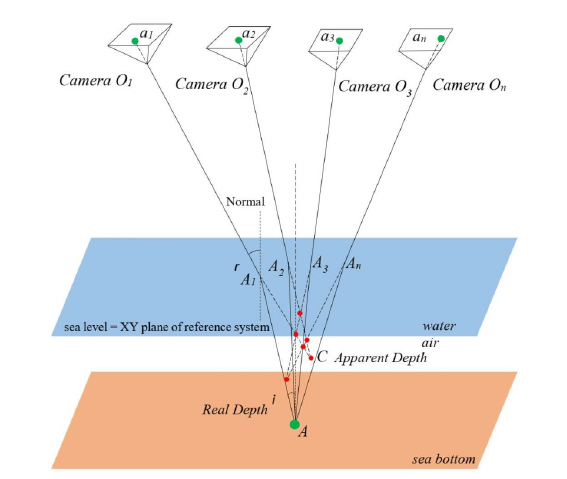
Figure 1. The geometry of two-media photogrammetry for the multiple view